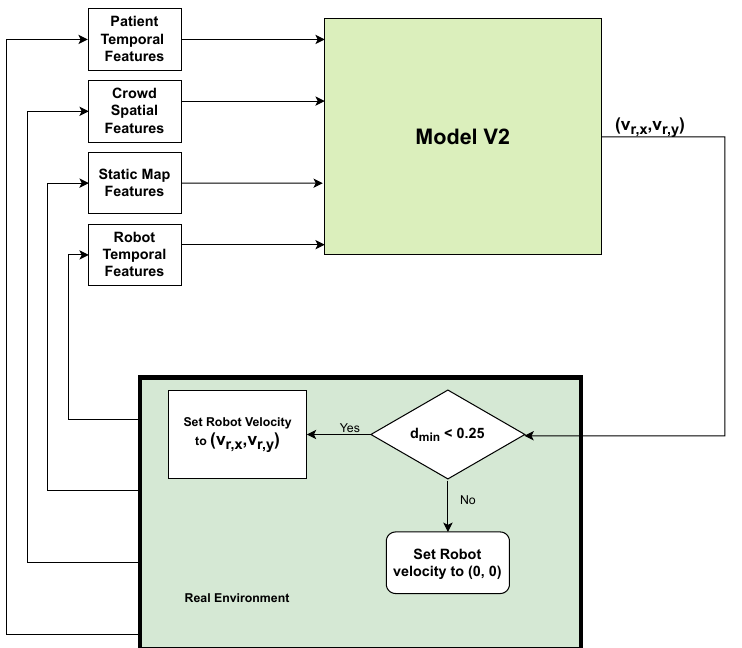
Figure 8. Flowchart of how the Model V2 is used to control the robot in a realistic Gazebo